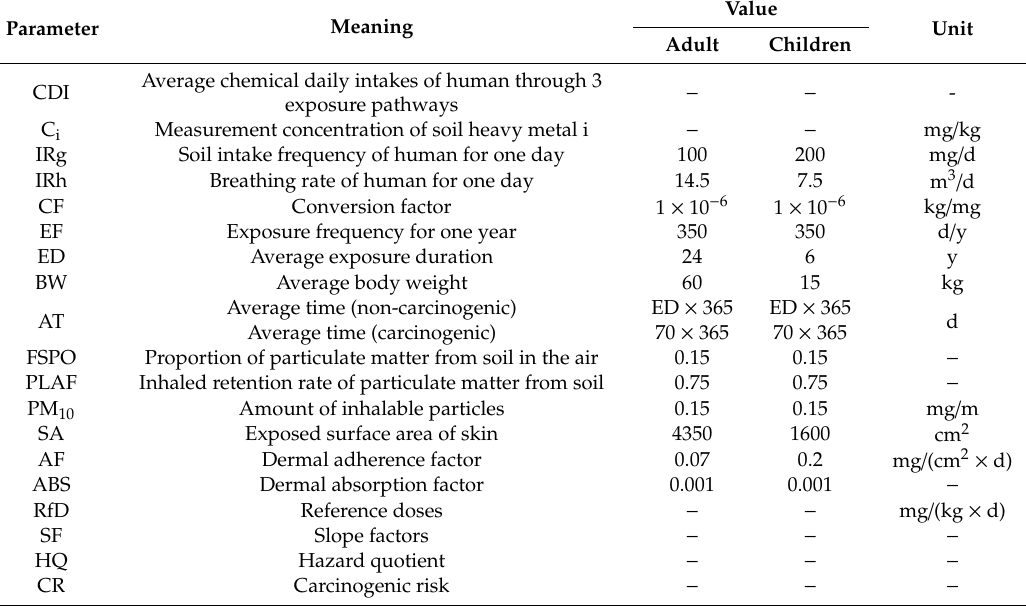
Table 1. Meaning of parameters in carcinogenic and non-carcinogenic risk